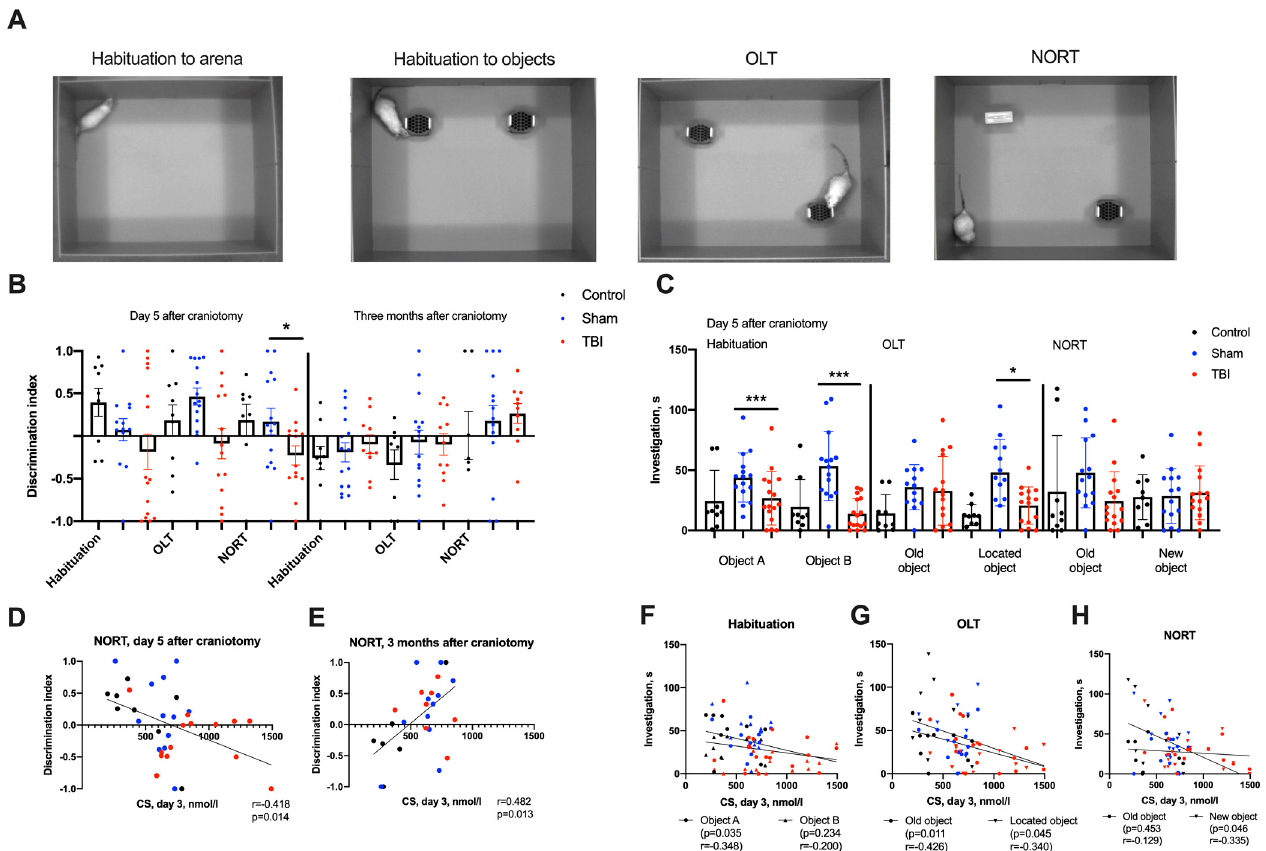
Figure 2. Behavior in OLT and NORT in acute and remote (3 months) periods after TBI. ( A )—The order of the behavioral tests. ( B )—Discrimination indices in OLT and NORT on day 5 and at 3 months after craniotomy. The discrimination index was lower in NORT during the acute posttraumatic period. ( C )—Cumulative duration of object investigation in OLT and NORT during the acute posttraumatic period. Rats after TBI investigated objects less during both habituation and during OLT. ( D , E )—Correlation of CS levels on day 3 after TBI with the discrimination index in NORT in the acute and remote posttraumatic periods (Spearman correlations). ( F – H )—Correlation of CS levels on day 3 after TBI with cumulative durations of object investigation during habituation, OLT and NORT (Spearman correlations). *— p < 0.05, ***— p < 0.001, Kruskal–Wallis test with